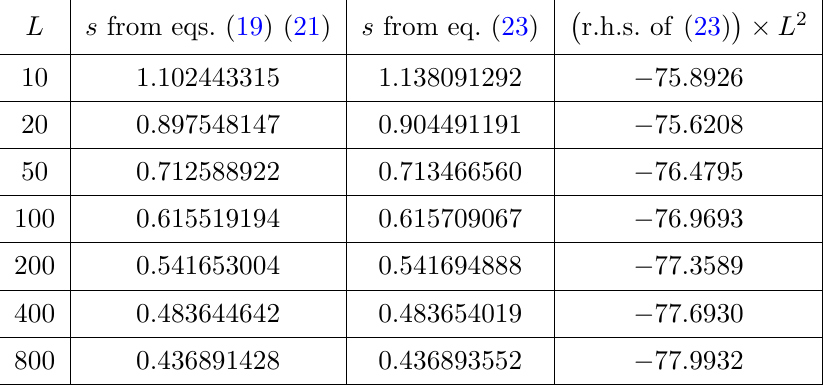
Table 1. In the second column the values of s were obtained by solving the BA equations for increasing L with the parameters (cid:13) = (cid:25) ( n = 4), k = 1 , S z = 4, m = 4 and then using eqs. (19) (21). 6 5 These are compared with predictions coming from the quantization condition (23). In the last column s obtained from the BA equations is substituted into the l.h.s. of eq. (23) to measure the (cid:0) (cid:1) corrections O (log L ) (cid:0)1 . It indicates that for n = 4 these corrections are of the order L (cid:0) 2+ (cid:15) with (cid:15) !